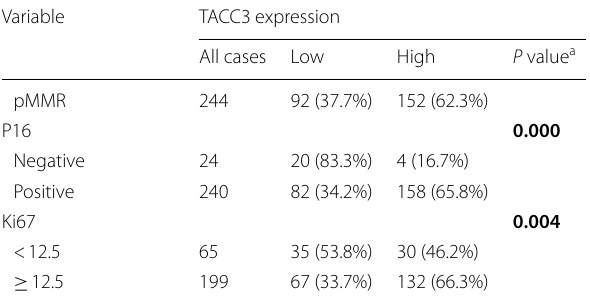
Table 1 Correlation of clinicopathological parameters